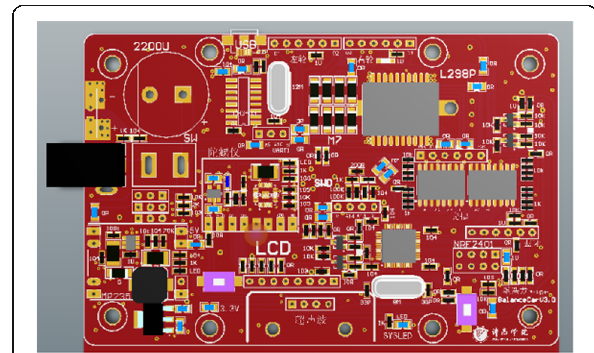
Fig. 34 Physical diagram of the balancing vehicle